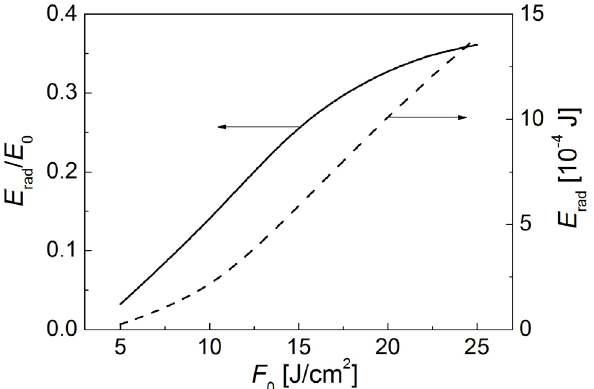
Figure 7. The total energy E rad radiated by the plasma plume during its expansion into vacuum as a function of laser fluence [50]. E 0 is the incoming pulse energy. The plume is produced by ablation of graphite with Nd:YAG laser pulses (7 ns, 532